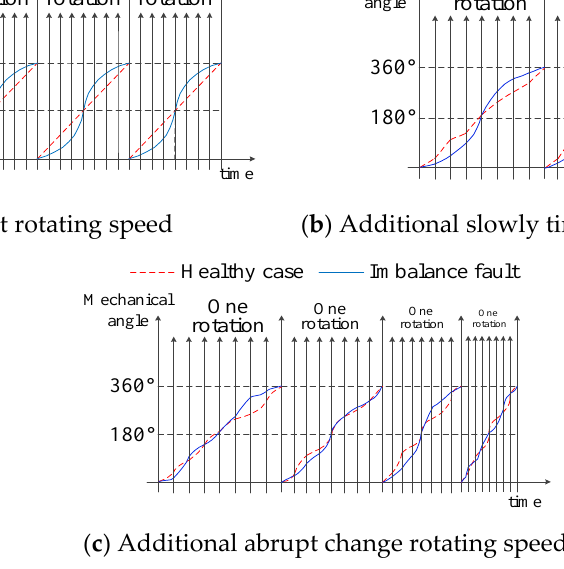
Figure 5. Mechanical phase affected by interference.